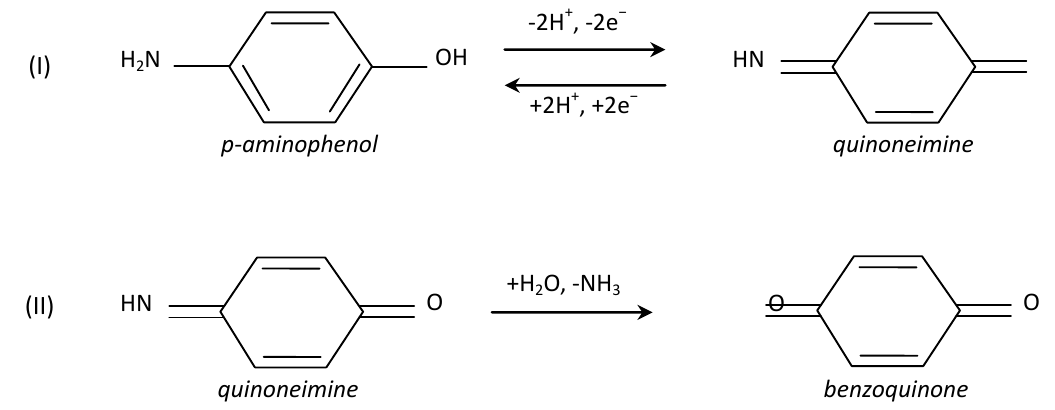
Figure 10. ( I ) Redox transition from PAP to quinoneimine. ( II ) conversion from quinoneimine (the intermediate product of PAP degradation) to benzoquinone, one of the possible final products of